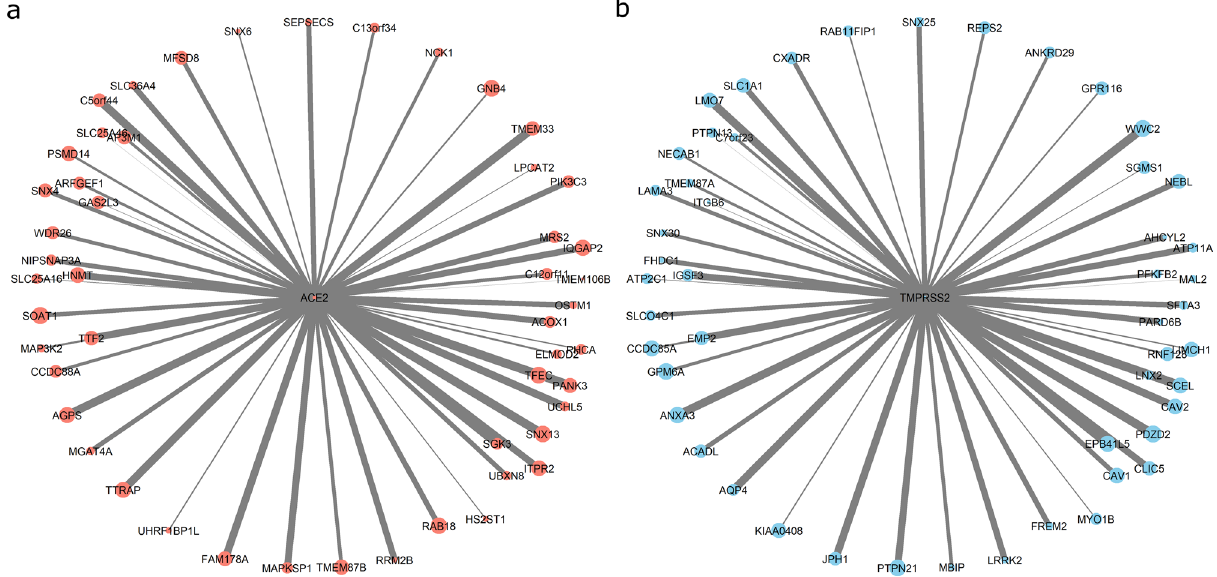
Figure 1. ACE2 and TMPRSS2 coexpression modules. The center of each graph represents ACE2 (a) or TMPRSS2 (b), the circles at the edges represent the top 50 genes with the highest connectivity to ACE2 or TMPRSS2 based on the WGCNA analysis. The circle size represents the size of each gene node in their respective modules. The arm thickness represents the relative strength of the connection to the ACE2 or TMPRSS2 expression. Figure was created using R 3.6 (https ://www.r-proje ct.org/) 11 .